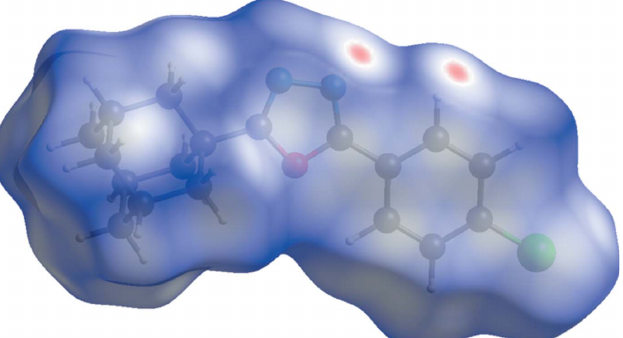
Figure 7 A view of the Hirshfeld surface mapped over d norm for compound (II) over the range (cid:5) 0.203 to 1.273 arbitrary units.